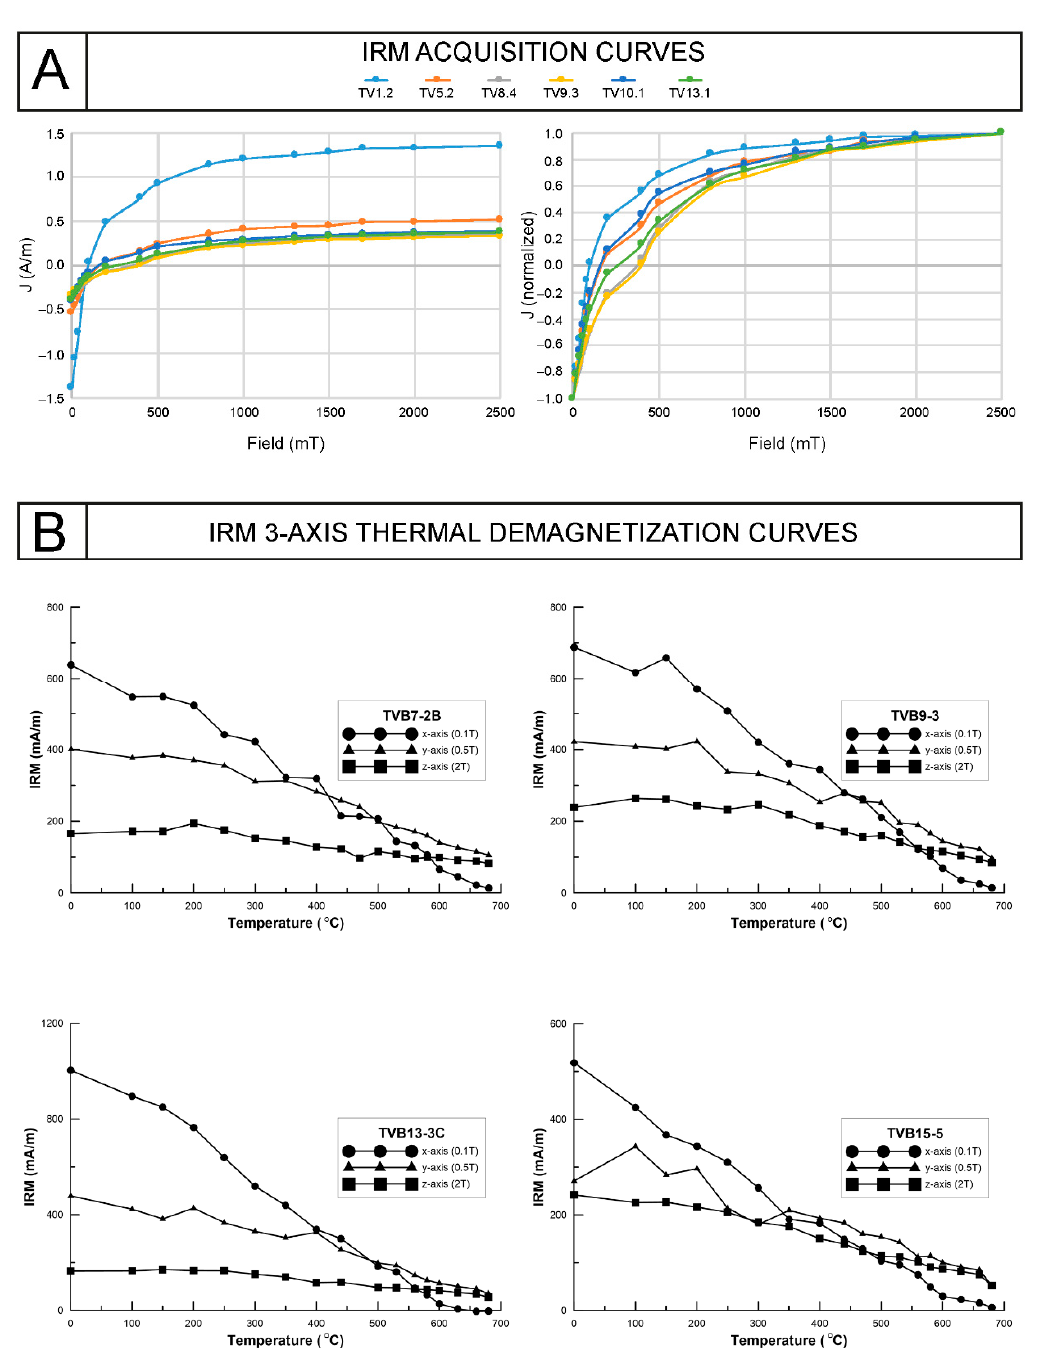
Figure 5. ( A ) Isothermal remanent magnetization (IRM) backfield acquisition curves and ( B ) thermal decay curves of three-axis IRM of selected samples from Tsiotra Vryssi (see Figure 4 for location).